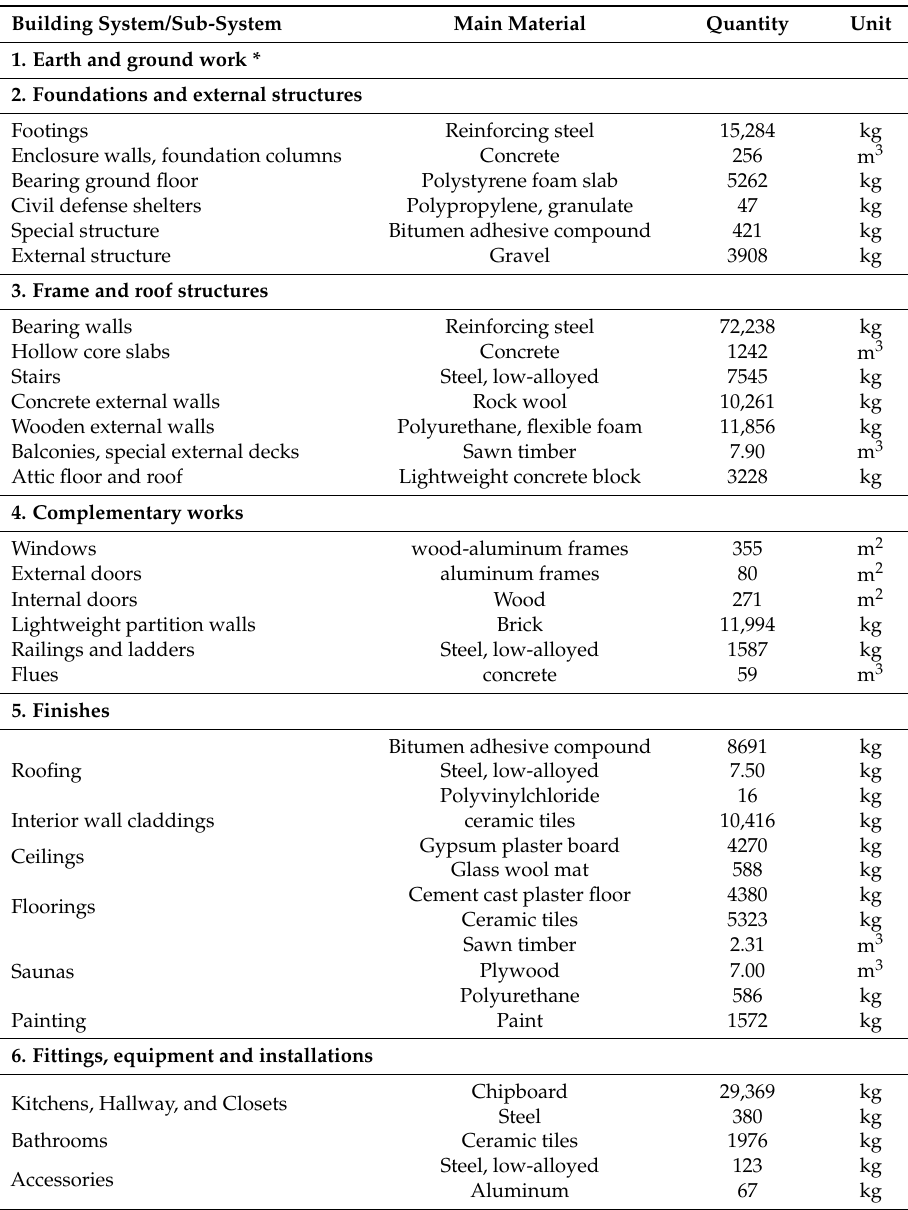
Table 1. The eight main building systems of Pyry and the main materials in each system (modified from a table published in Heinonen et al.